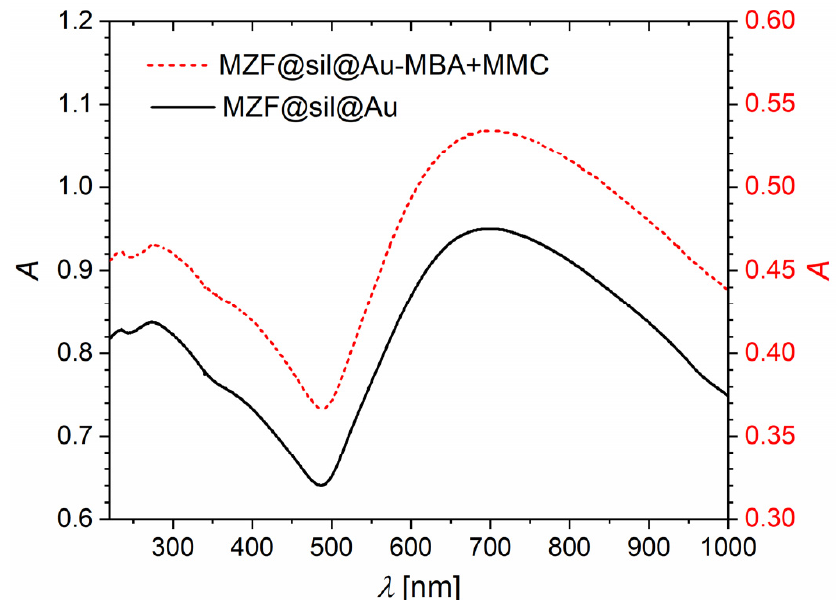
Figure 4. UV-Vis spectra of bare gold nanoshells (MZF@sil@Au, left axis) and gold nanoshells functionalized with the combination of MBA and MMC (MZF@sil@Au-MBA+MMC, right axis).